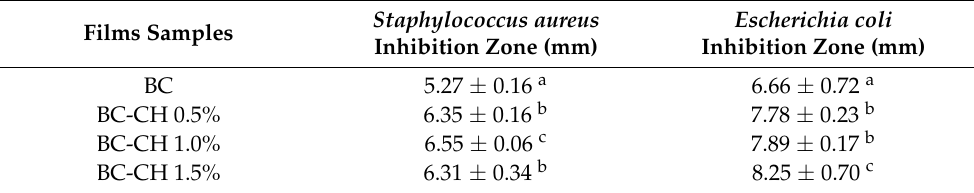
Table 1. Antimicrobial activity of BC and BC-CH films coated with various concentrations of chitosan. Films Samples